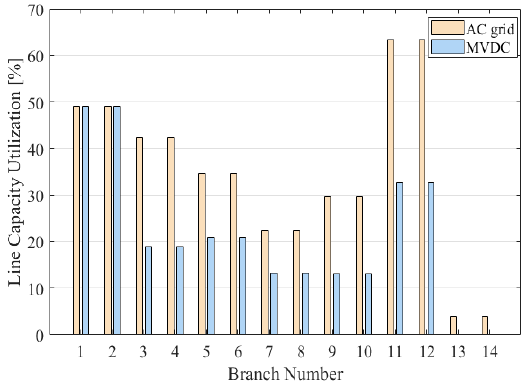
Figure 9. Comparison of two objective functions in Area 1.